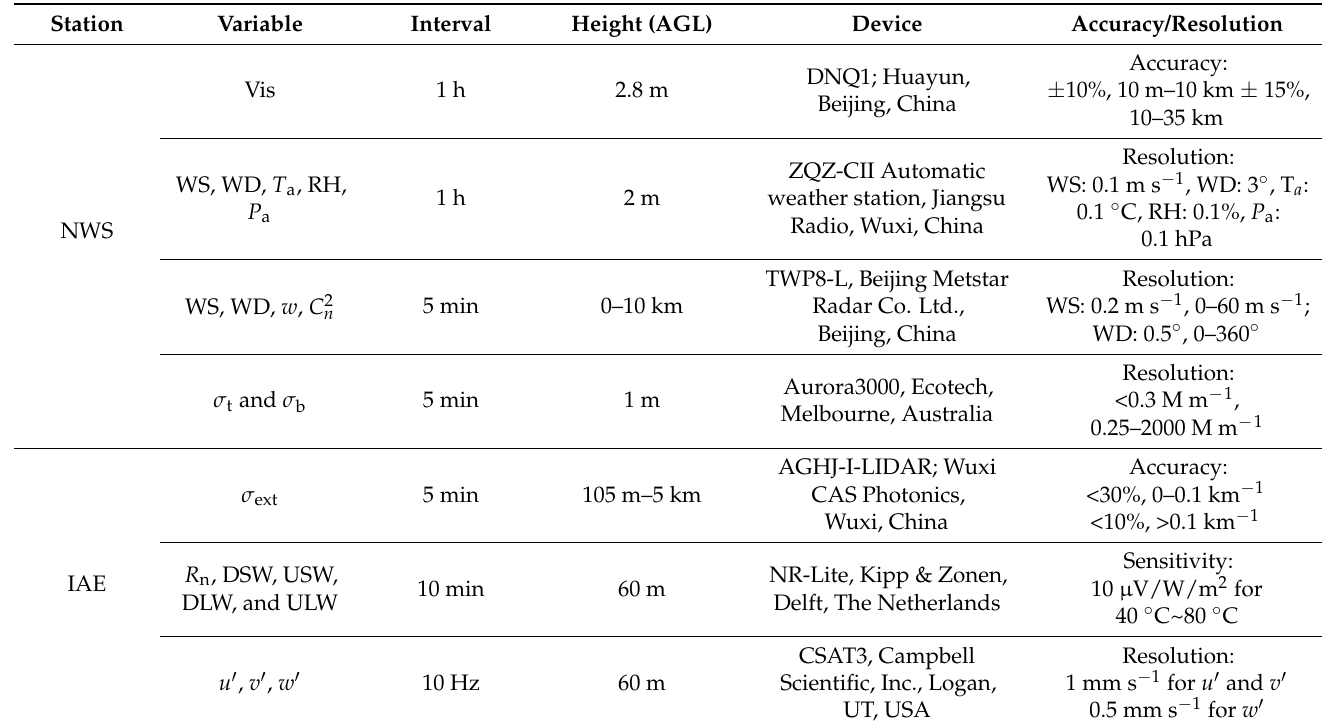
Table 1. Observational variables and devices at the two stations in Shenyang 1